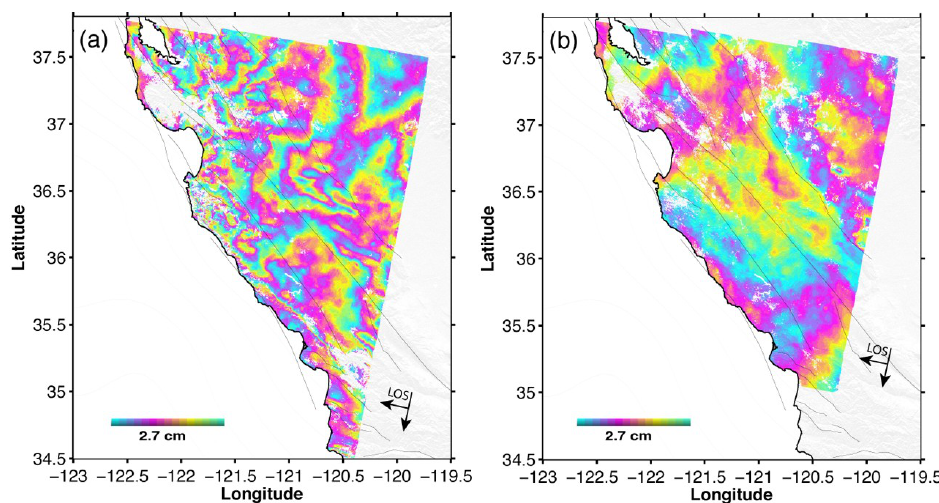
Figure 3 . Selected Sentinel‐1 interferometric wide‐swath (IW) mode interferometry of two pairs: ( a ) 2017/04/07–2017/04/19; ( b ) 2016/04/12–2016/05/06. The unwrapped phase is rewrapped at 2π radian (corresponding to 2.7 cm) to better reveal phase (displacement) variation. Each fringe represents the surface displacement of 2.7cm along the satellite line‐of‐sight (LOS). Both images are dominated by atmosphere noise.